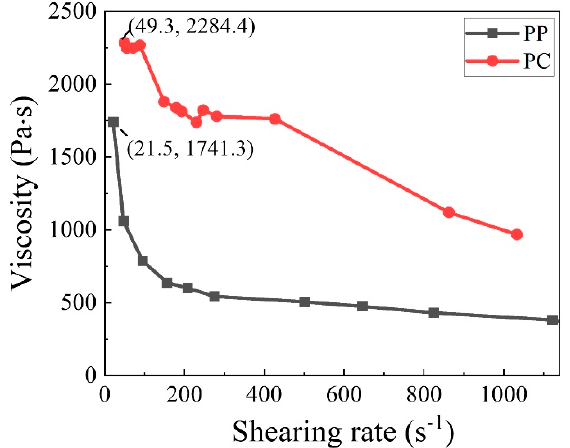
Figure 5. The viscosity curves of PP and PC.